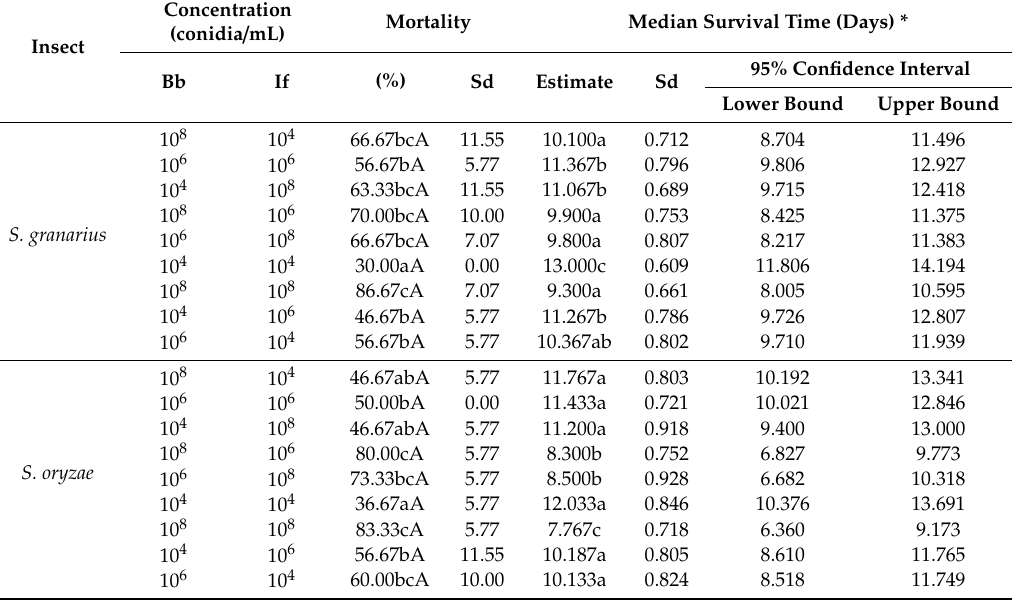
Table 2. Mean mortality and median survival time of adults of S. granarius and S. oryzae treated with B. bassiana (Bb) and I. fumosorosea (If) in